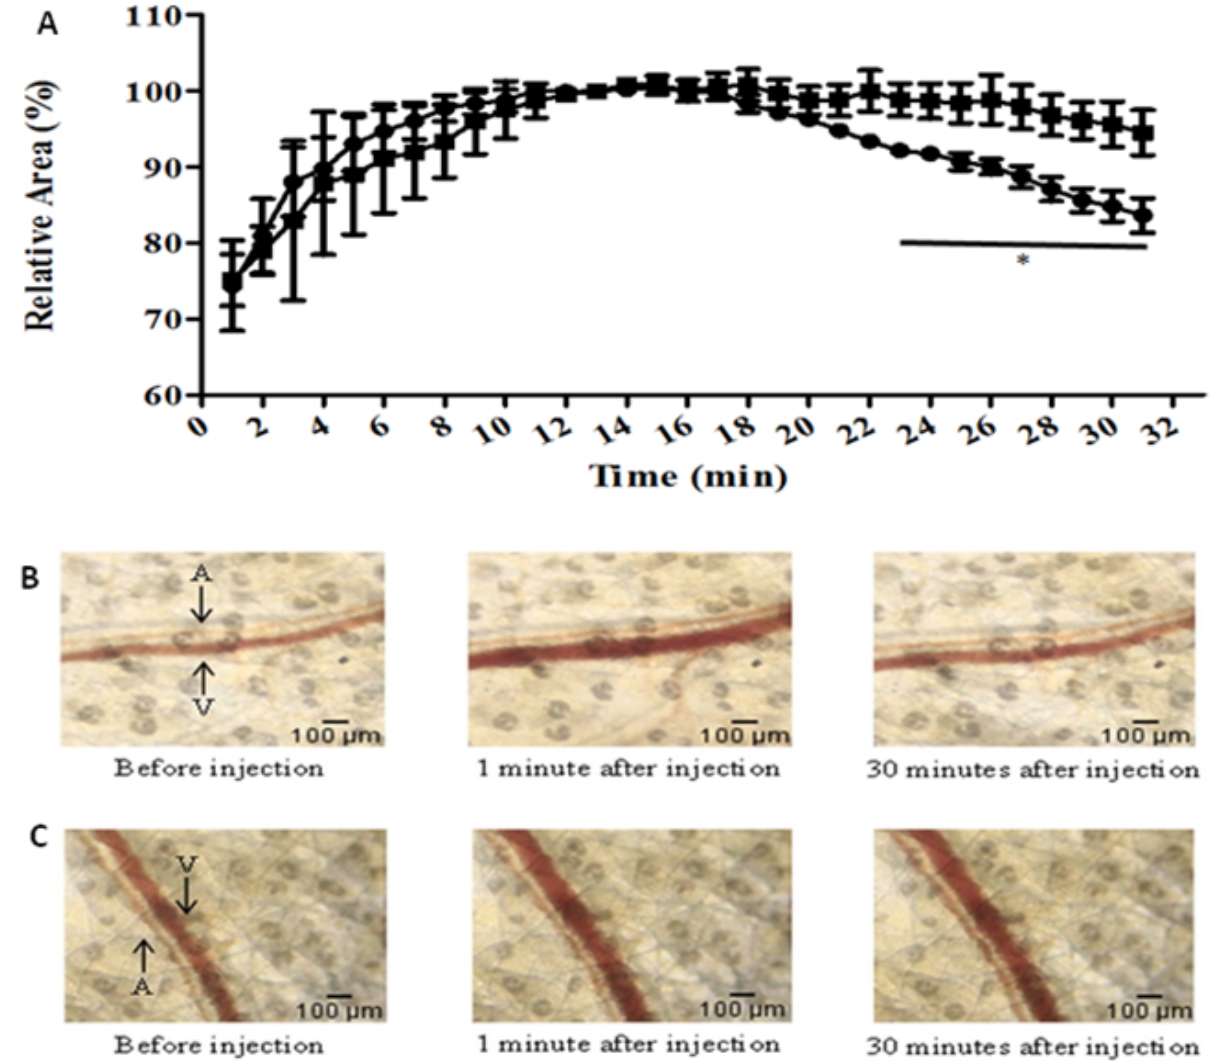
Figure 6. Effect of triapsin in mouse skin microcirculation. (A) Mouse ear venular modulation was analyzed upon triapsin stimulation by intravital microscopy. The control consists of the same volume of PBS pH 7.4. The graphic represents the mean increase in venular area upon injection of triapsin (rectangle) (n = 4) or PBS (circles) (n = 5). The maximum vasodilation obtained was considered 100%. Two-way ANOVA with a post t-test (unpaired t-test) were used to analyze the differences (*p < 0.05). The mean ± SEM is shown. (B) Diameter variation of mouse ear venules at indicated time points after intradermal microinjection of PBS (pH 7.4) (69 nL). (C) Diameter variation of mouse ear venules at indicated time points after intradermal microinjection of triapsin (69 nL; 15.1 µM). In the images, arteriole (A) and venule (V) are indicated by